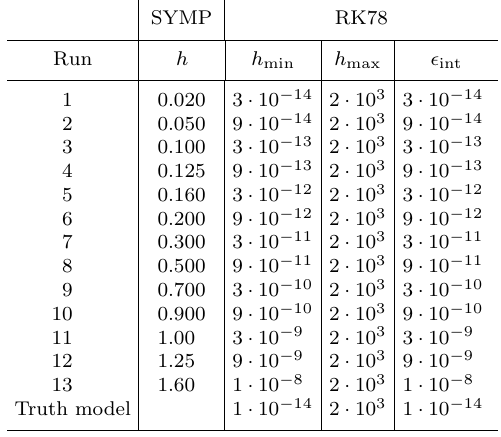
Table 1. Choices of integration parameters for each